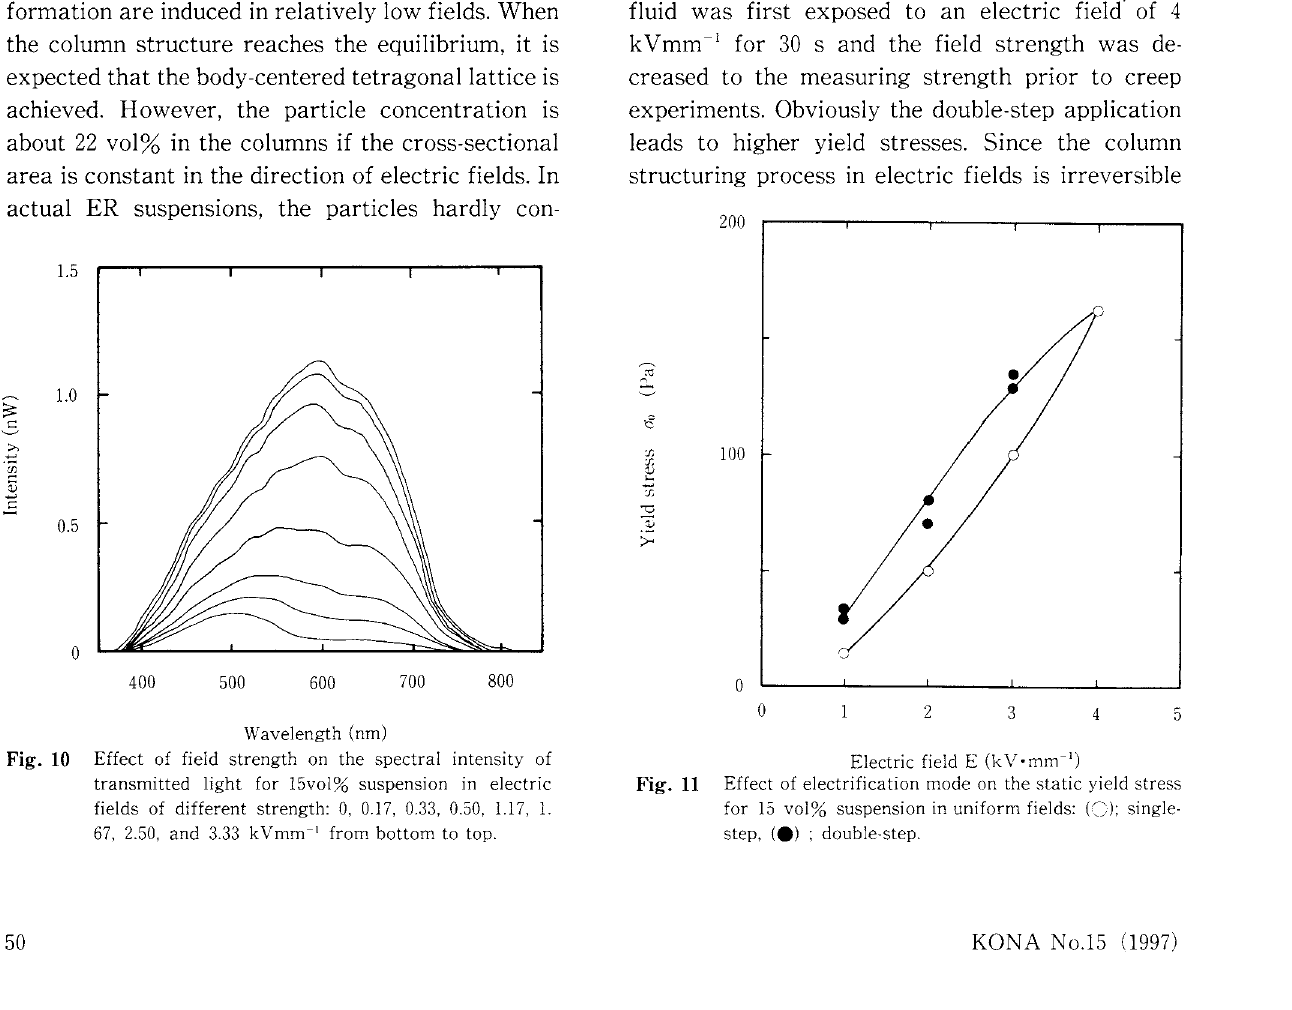
Fig. 10 Effect of field strength on the spectral intensity of transmitted light for 15vol% suspension in electric fields of different strength: 0, 0.17, 0.33, O.SO, 1.17, 1. 67, 2.50, and 3.33 kVmm- 1 from bottom to